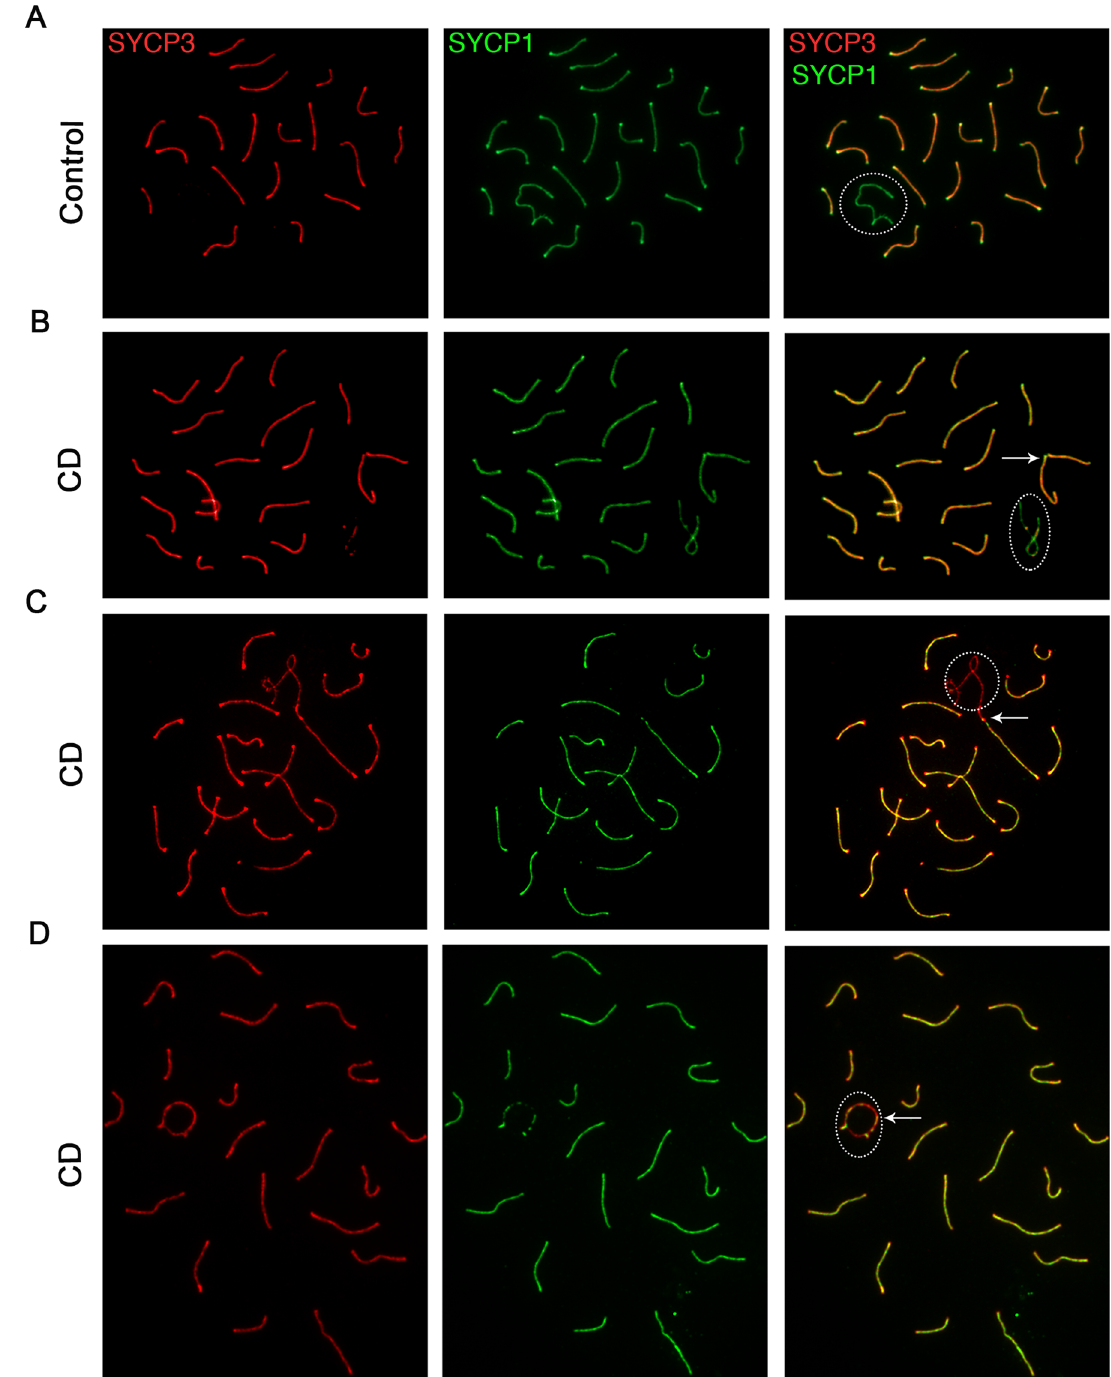
Figure 3. Gestational exposure to CD affects meiotic synapsing in F1 and F3 CD-derived males. Surface spreads were prepared from F3 generation testes obtained from control ( A ) or CD-derived males ( B – D ) males as described in the Methods section. The spreads were immunostained for a major protein of the lateral element of the synaptonemal complex (SC), SYCP3 (red, left panel), and for a protein expressed in the SC central element, SYCP1 (green, middle panel); the overlap between the two is also shown (right panel). ( A ) Representative images of a control testis spread. Normally, SYCP3 is detected along the length of every chromosome, while SYCP1 is expressed on all autosomal chromosomes and is visible as a punctate signal or absent immunostaining pattern in sex chromosomes (dashed circle, right panel). ( B , C ) In CD-derived males, meiotic cells with telomere connections and ring-like structure of sex chromosomes are notable. ( D ) The formation of “ring” like structures in sex chromosomes. X and Y sex chromosomes (sex bodies) are shown (dashed circle). The arrows point to chromosomes where telomeres are completely closed or